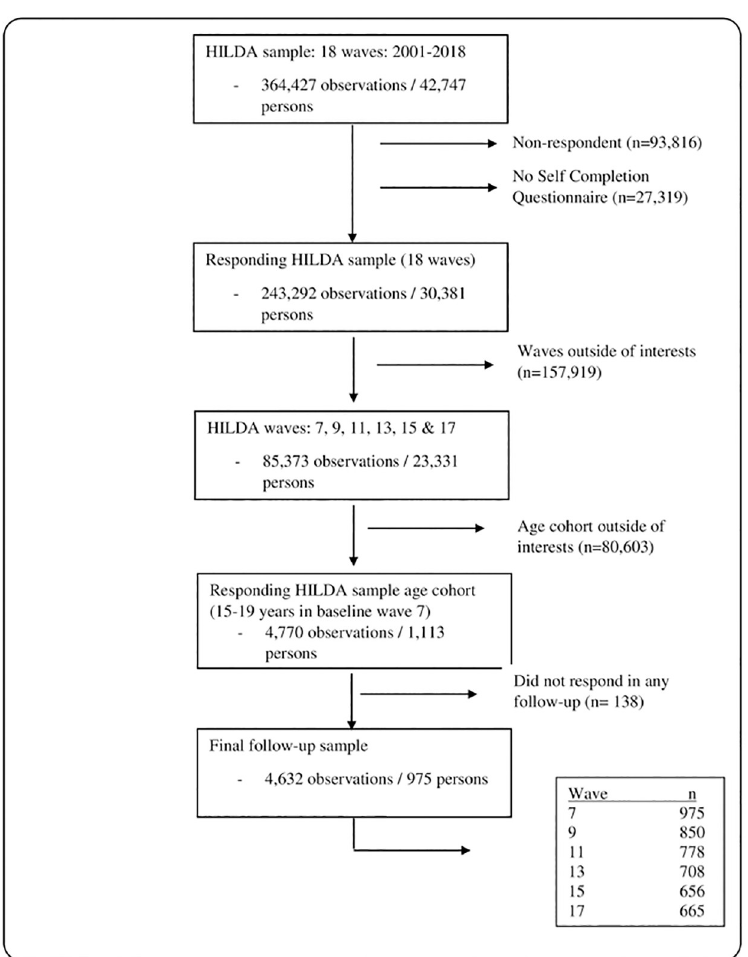
Fig 1. Participants flow into the